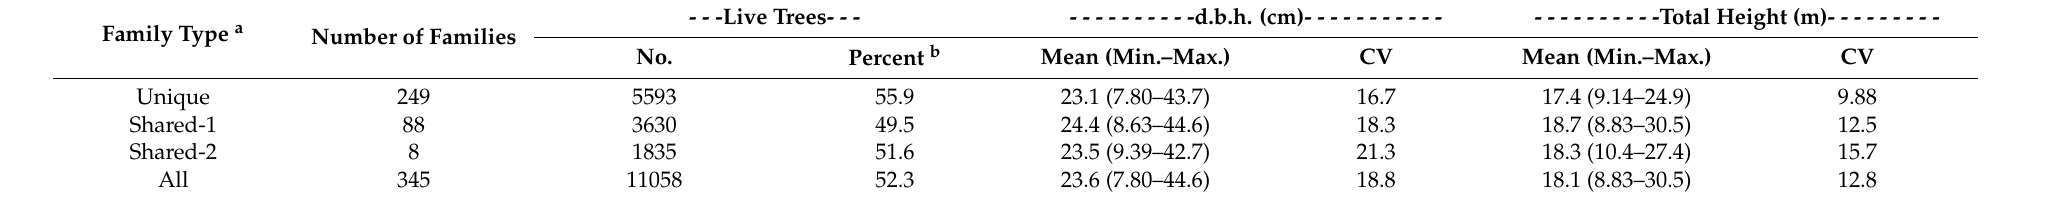
Table 2. Statistics on the shortleaf pine family types remeasured in